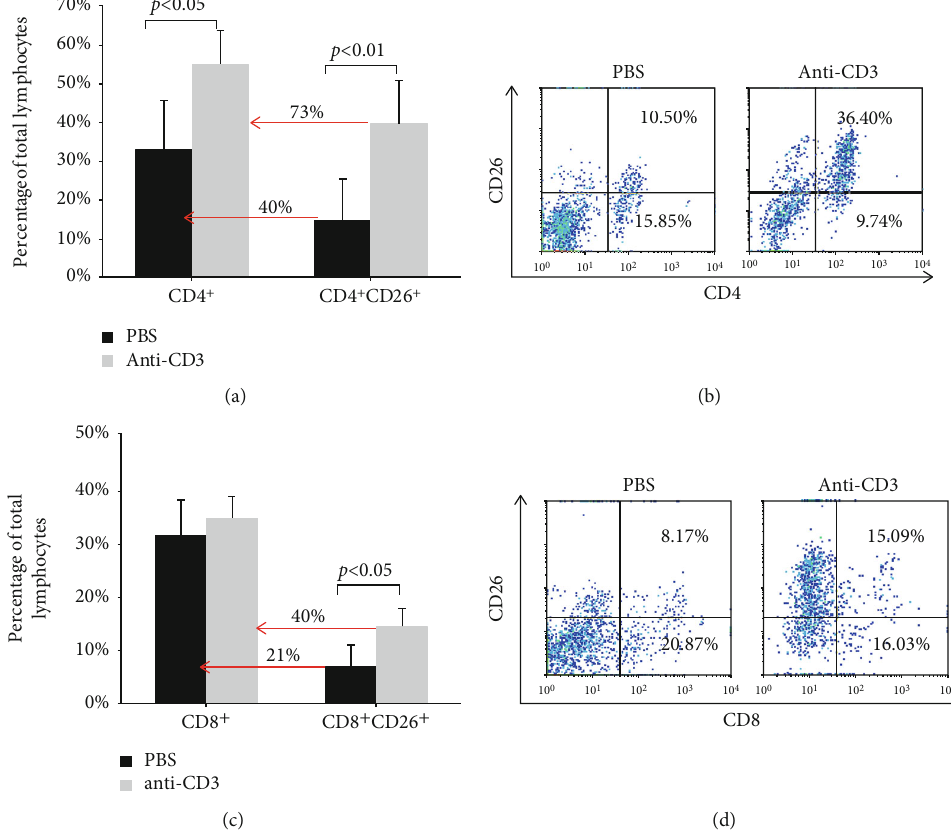
Figure 2: Percentages of CD4 + and CD8 + cells and cells coexpressing each of these surface markers with CD26 after stimulation. (a) Percentages of CD4 + and CD4 + CD26 + cells in the control group and the stimulated group. (c) Percentages of CD8 + and CD8 + CD26 + cells in the control group and the stimulated group. Data represented mean value ± SD from fi ve independent experiments with fi ve healthy donor HPBL samples, and each experiment was repeated more than three times. p values were calculated with a chi-square test. The dot plots show one typical experiment for the analysis of (b) percentages of CD4 + and CD4 + CD26 + cells and (d) percentages of CD8 + and CD8 + CD26 + cells by fl ow